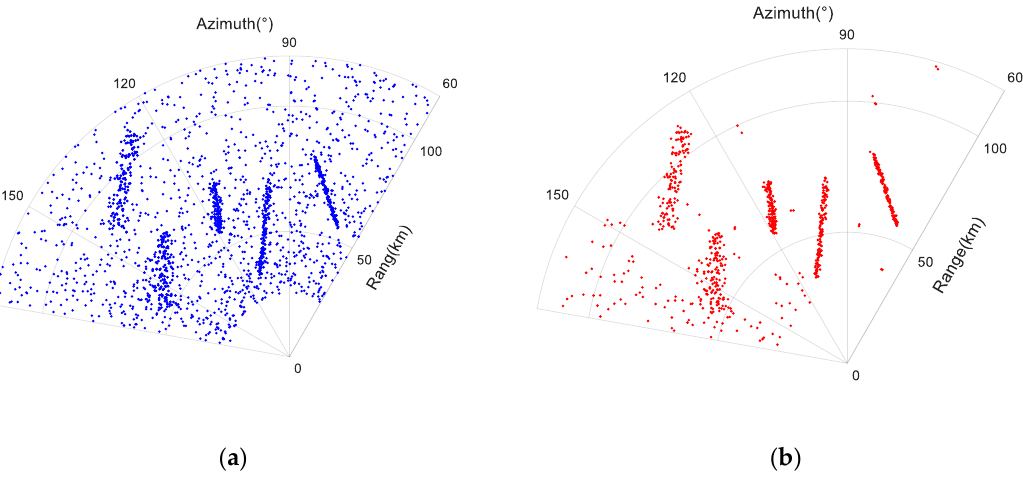
Figure 9. Contrast of before and after the suppression: ( a ) simulated data before suppression; ( b ) clutter suppression result. Table 3. The performance indexes of the suppression